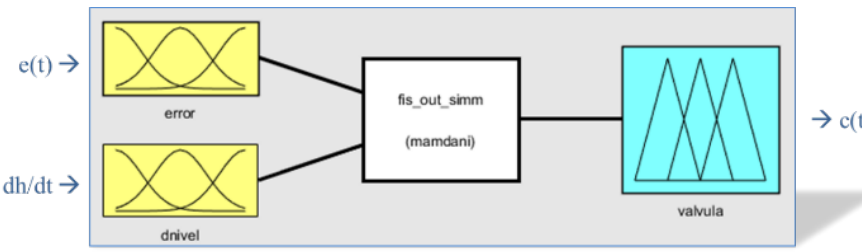
Figure 6. Fuzzy controller implemented using the Simulink toolkit.